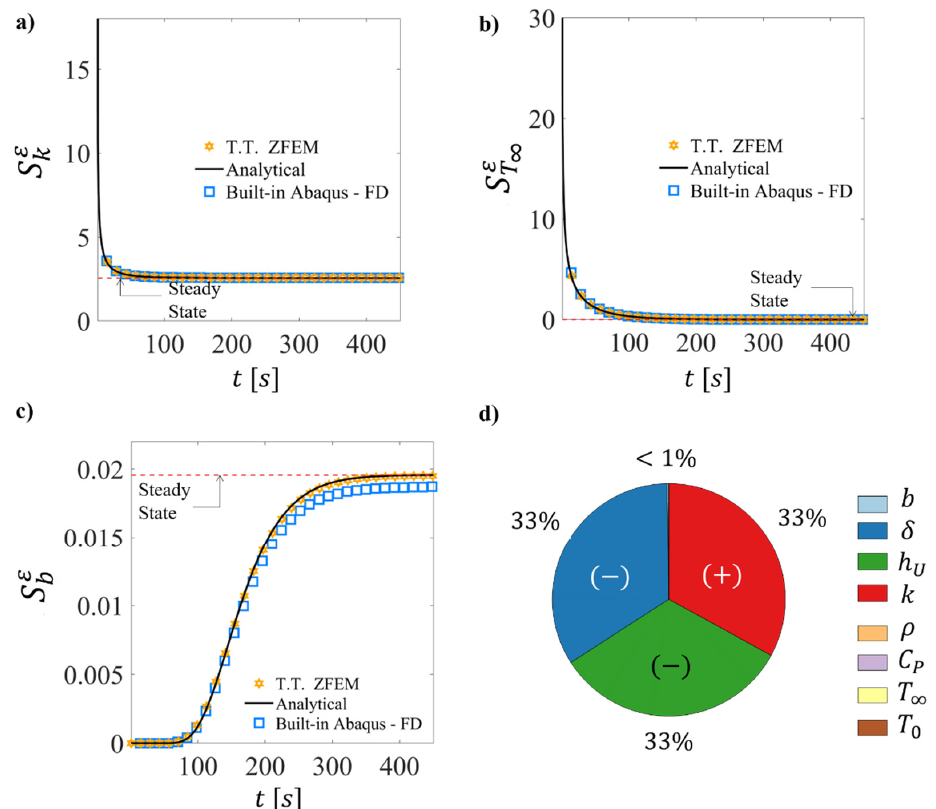
Figure 10. Thermal effectiveness sensitivity history in fin tip to ( a ) thermal conductivity; ( b ) room temperature; ( c ) fin length. Solid black line, analytical sensitivity using analytical differentiation in Equation (26), yellow star, sensitivity using Transient Thermal ZFEM, blue square, sensitivity using 1% FD and Abaqus built-in element solutions, thin red dashed line, sensitivity using analytical differentiation for steady-state using Equation (26). ( d ) Steady-state influence of fin parameters in ε based on relative sensitivities. In the pie chart, the missing parameters ( b , ρ , C P , T ∞ , T 0 ) have an influence of less than 1% compared to the sum of all relative sensitivities. Moreover, the ( − ) in the pie sections implies an inverse relationship between the output variable and the input parameter, while a (+) parameter has a direct relationship with the